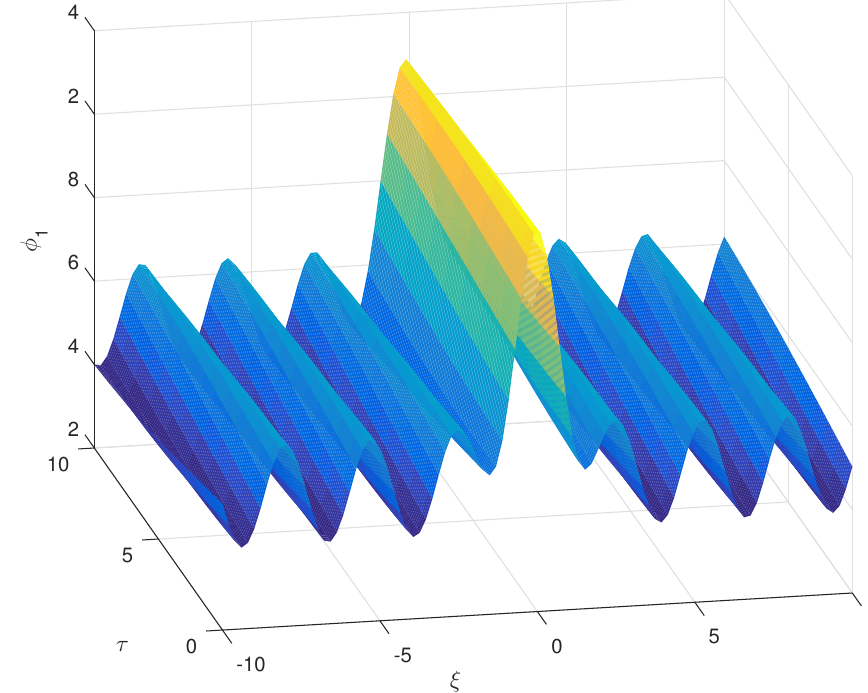
Figure 11. The 3D form of the nanopteron